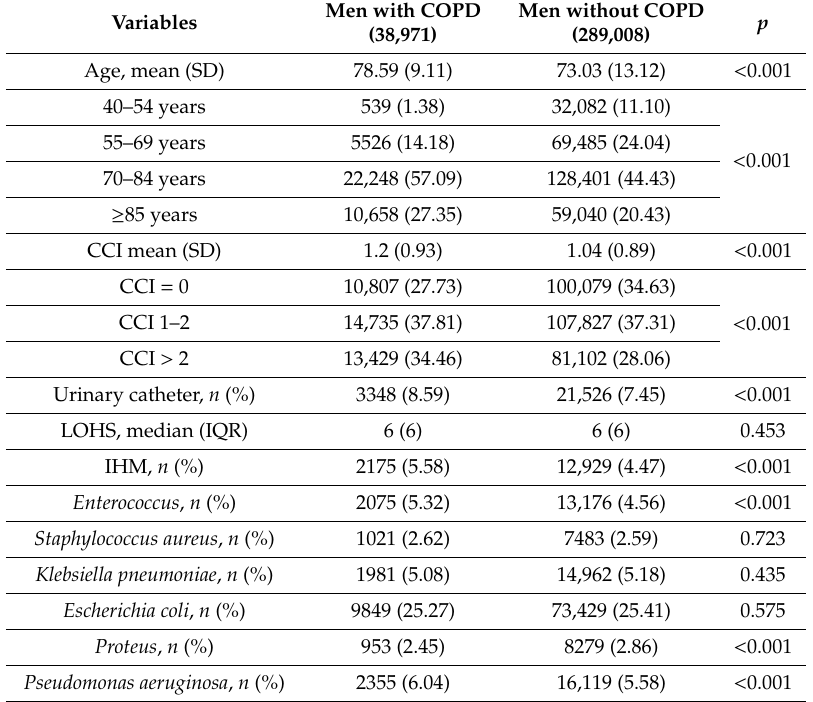
Table 1. Age distribution, comorbidities, procedures, in-hospital outcomes and isolated pathogens among men hospitalized with a principal diagnosis of urinary tract infection in Spain from 2001 to 2018, according to COPD